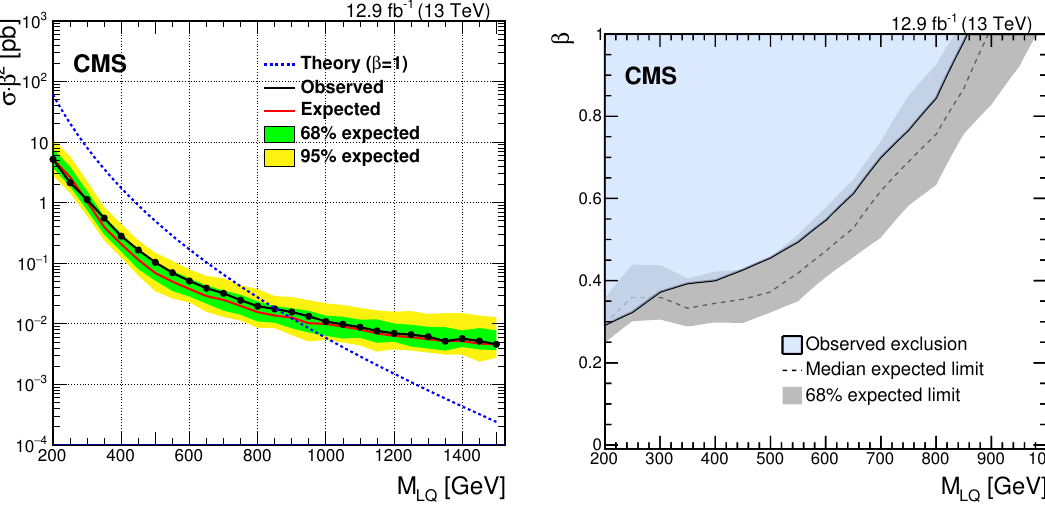
Figure 2 . Observed and expected limits at 95% CL on the product of cross section and branching fraction squared, obtained from the combination of the e (cid:28) h and (cid:22)(cid:28) h channels, in the LQ analy- sis (left) and 95% CL observed and expected exclusion limits on the LQ mass, as a function of (cid:12) (right). In the left plot, the green and yellow bands represent the one and two standard deviation uncertainties in the expected limits. The dashed dark blue curve represents the theoretical LQ pair production cross section, assuming (cid:12) = 100% [18, 19]. In the right plot, the grey band represents the one standard deviation uncertainty in the expected